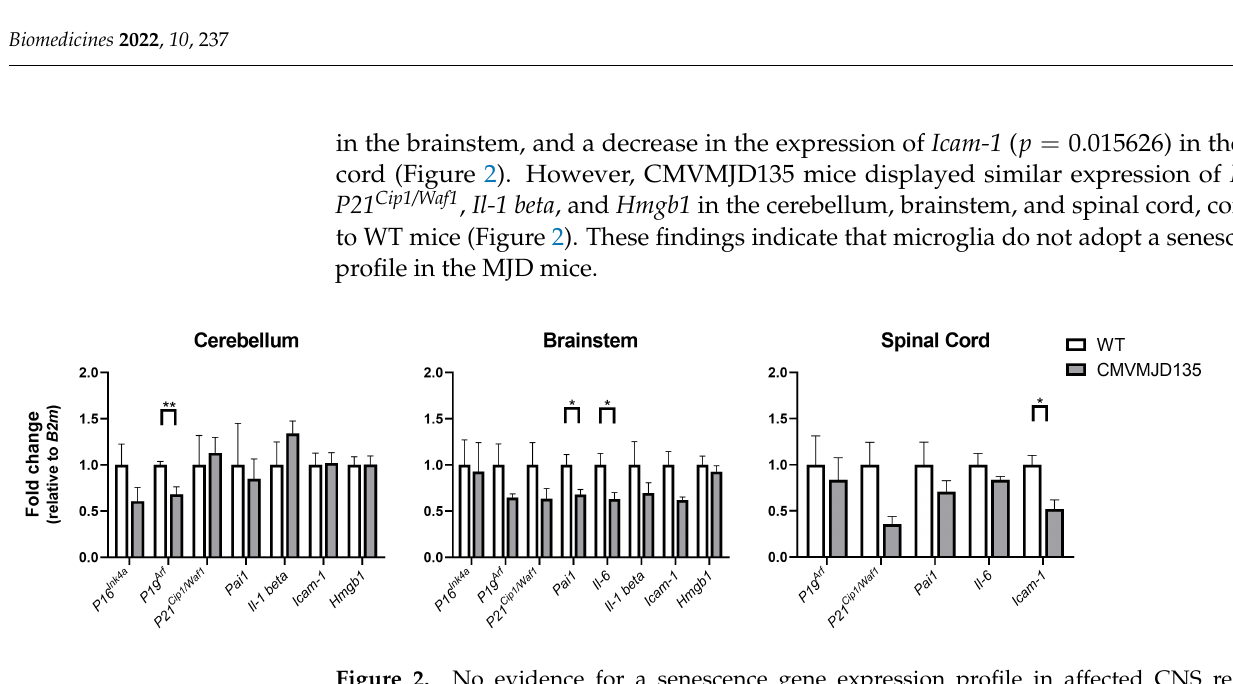
Figure 2. No evidence for a senescence gene expression profile in affected CNS regions of CMVMJD135 mice. The expression levels of senescence markers were analyzed in the cerebel- lum, brainstem, and spinal cord of 48 weeks-old WT and CMVMJD135 mice. n = 4–5 per group and two technical replicates were performed. Fold change (2 − ∆∆ CT ) is represented using B2m as a housekeeping gene. Data are presented as mean + SEM (Student’s t -test). *, **, represent p < 0.05 and p < 0.01,